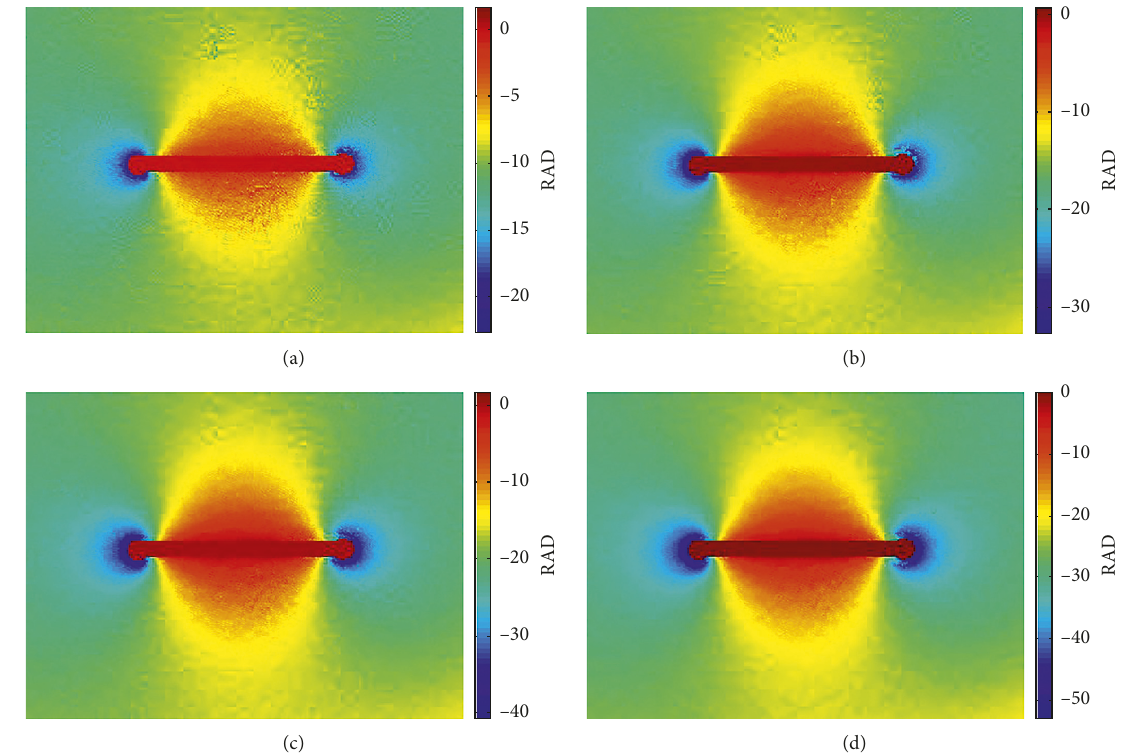
Figure 4: The unwrapped phase of the object wave through the PMMA specimen with a crack. (a) σ (c) σ 00 2MPa, and (d) σ 00 2.5 (cid:29) (cid:29)